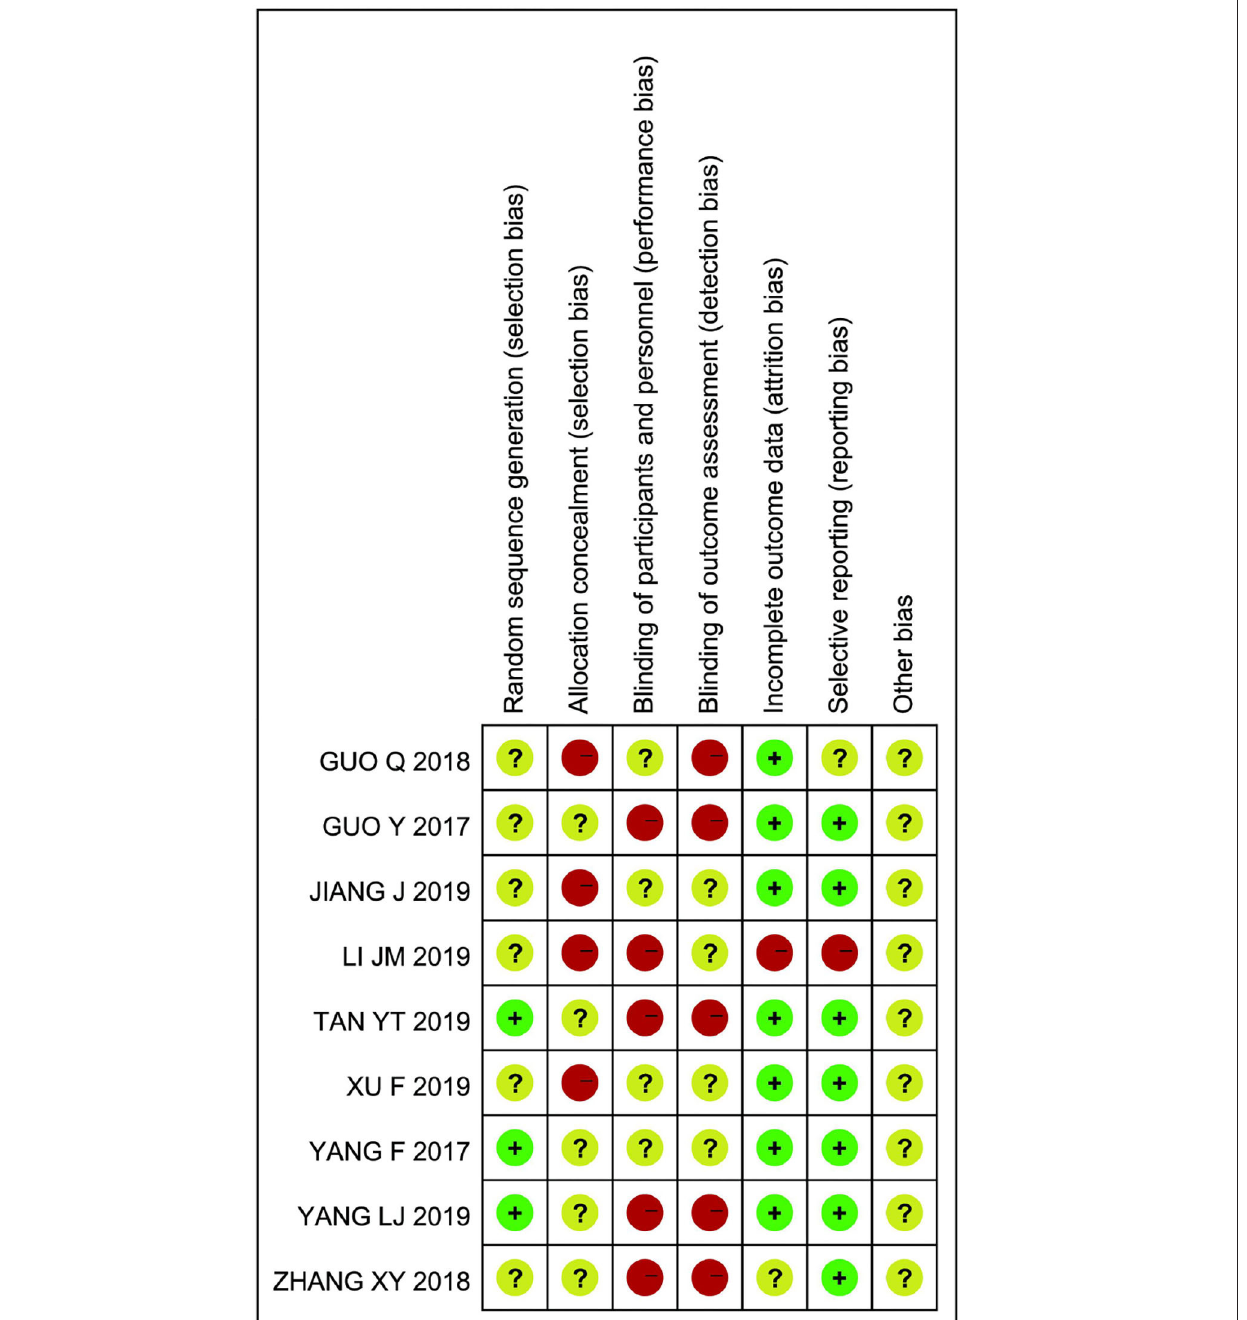
GnRH-a is a synthetic derivative of the gonadotropin- releasing hormone. It was first reported in 1991 for the treatment of adenomyosis and obtained good outcomes (25). GnRH-a can combine tightly with the GnRH receptors of the pituitary, so